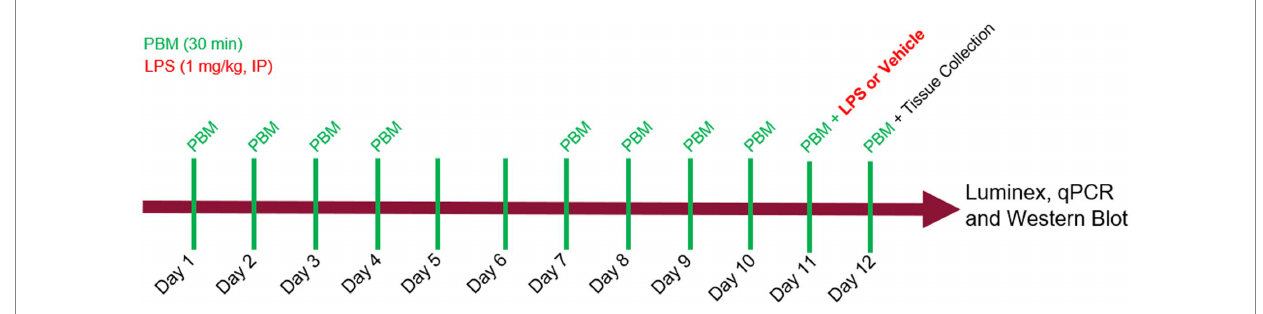
FIGURE 1 Experimental design. Photobiomodulation (PBM) was administered daily, for 30 min per day, on days 1 through 5 and days 8 through 12. On day 11, mice received either LPS (1 mg/kg) or vehicle injection, IP, 30 min after PBM. On day 12, mice received a final PBM treatment before tissue was collected at 24 hrs after LPS. Luminex, qPCR and western blot assays were performed on brain and plasma samples.